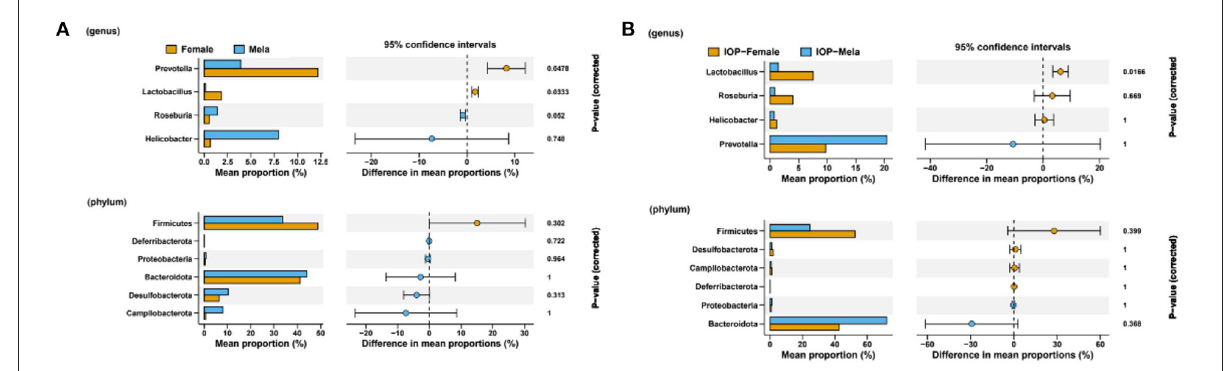
FIGURE6 Comparison of intestinal microflora between male and female SD rats. Welch’s two sample t-tests were performed to compare the control group (A) and the experimental group (B) with IOP intervention.